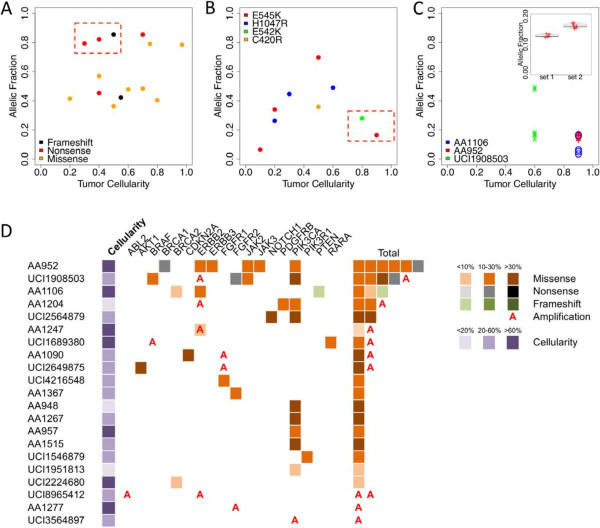
Patterns and actionability of somatic mutations. (A), (B) The allelic fraction of all TP53(A) and PIK3CA(B) nonsilent somatic mutants (y axis) is displayed as a function of the cellularity of the tumor (x axis). Red boxes indicate samples where the allelic fraction deviates from tumor cellularity. (C) The allelic fraction of the nonsilent somatic mutations in the three tumors showing evidence of two subclones is displayed as a function of the tumor cellularity (x axis). Inset: highlighting the distribution of allelic fraction of the mutations identified in the two clones of AA952. (D) Schematic representation of the type of somatic variation identified in the genes actionable for their somatic status. The tumor cellularity is displayed in a purple gradient color. The samples are ranked by decreasing number of actionable somatic mutations.